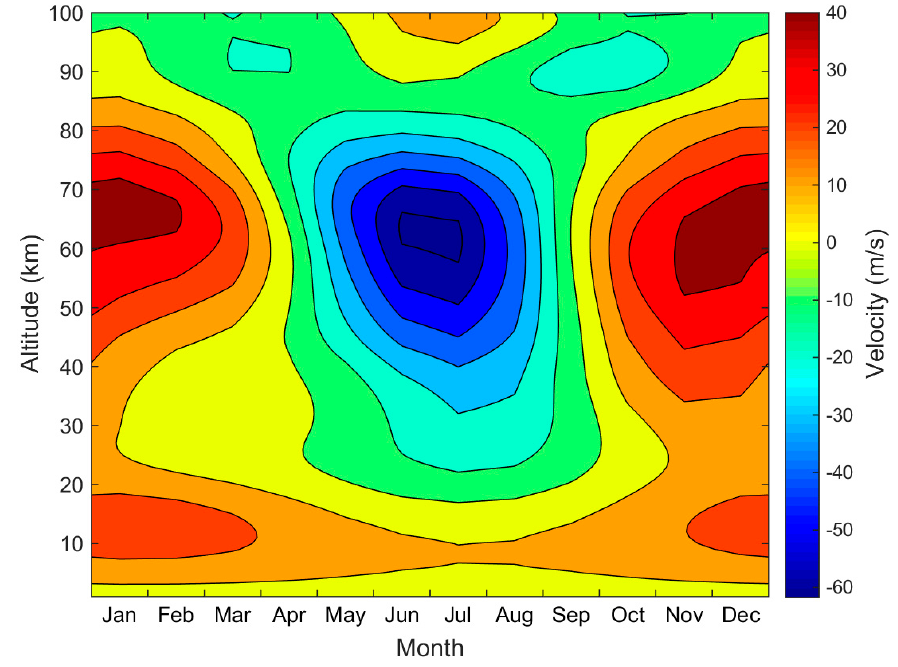
Figure 5. The mean horizontal wind diagram of Northern China.